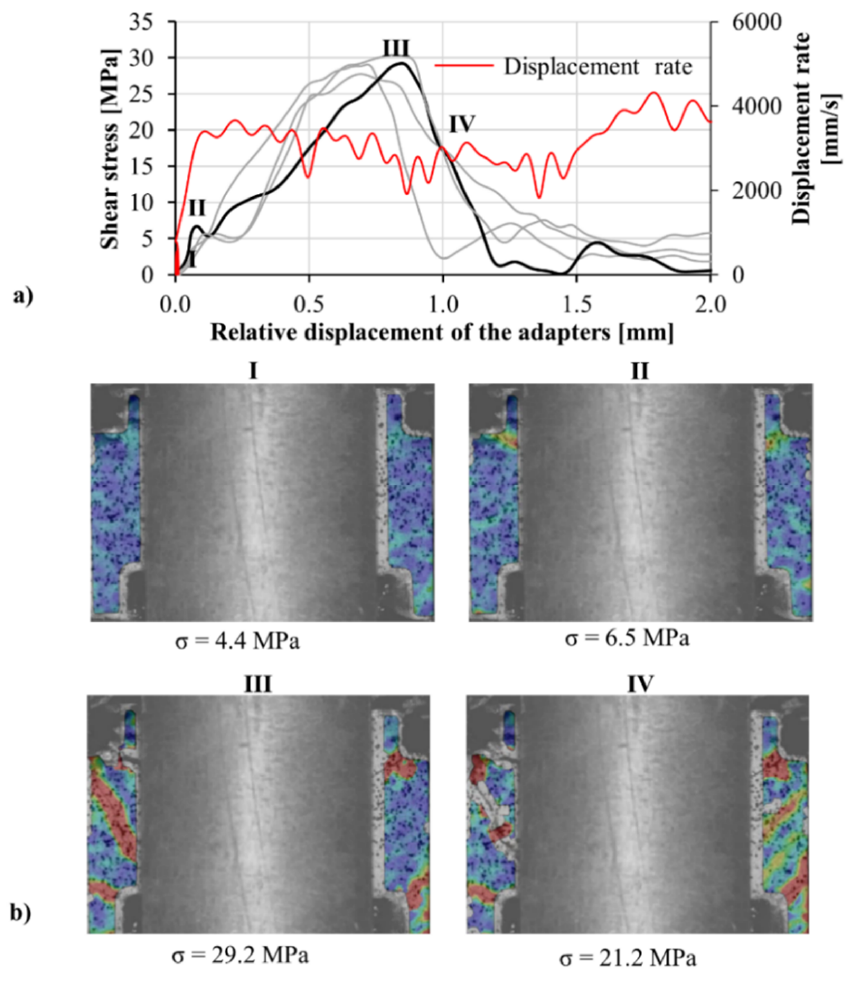
Figure 16. ( a ) Shear stress versus displacement curves obtained in the confined impact shear tests on M1-6PE SHCC, and ( b ) a representative DIC sequence showing the first principal strain field in the shear zones for various stress levels corresponding to the thicker black curve.